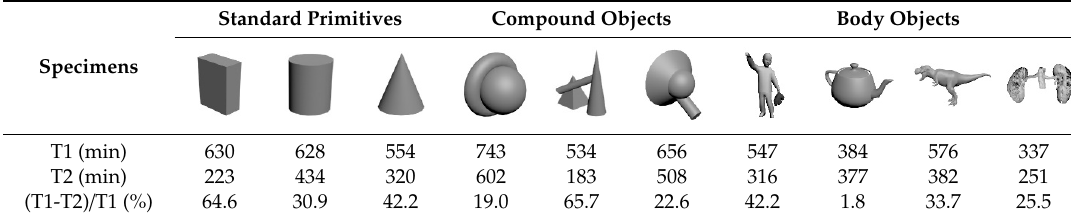
Table 2. Measurements and differences of printing time of ten random 3D models.